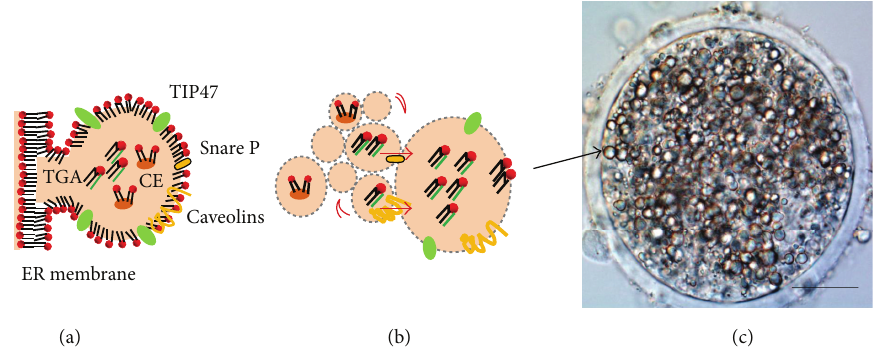
Figure 2: A model for lipid droplets (LD) biogenesis ((a), (b)) during pig oocyte (c) maturation: (a), de novo synthesis of LD in endoplasmic reticulum membrane and (b) LD coalescence process, with lipid trafficking mediated by snare (Snare P, orange batons) and caveolins (orange coiled lines) proteins (based on a study by Suzuki et al. [18]). Perilipins proteins (TIP47 green batons) involved in the mechanism of lipolysis regulation. (c) Pig oocyte with 24 hours of in vitro maturation. Scale bar 50 𝜇 m. CE, cholesterol esters; ER, endoplasmic reticulum; TGA, triacylglycerols.